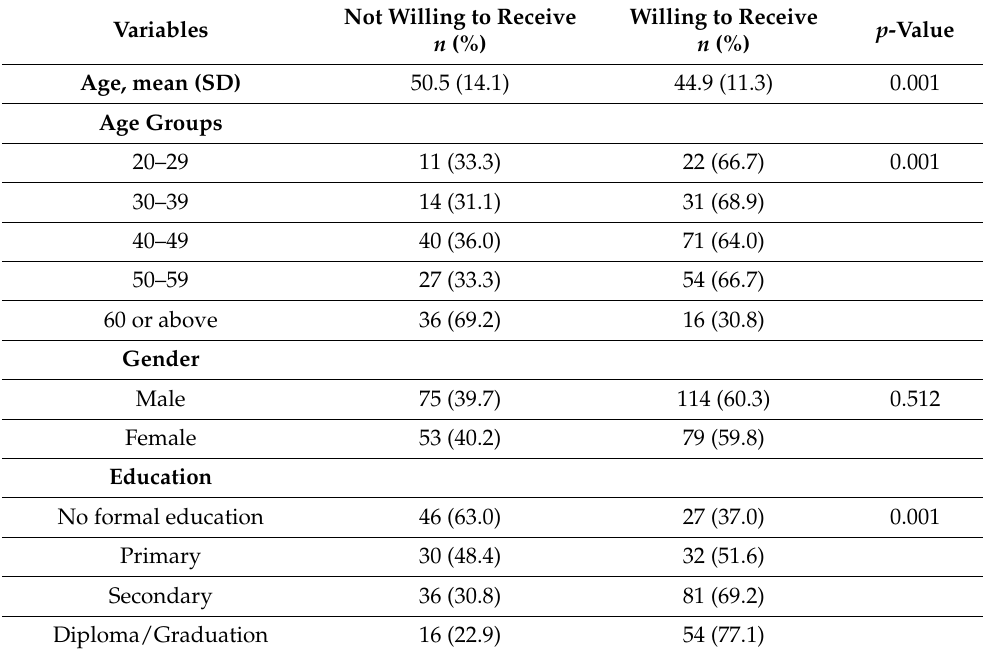
Table 4. Demographics of unvaccinated patients by their willingness to receive their vaccine. (n =